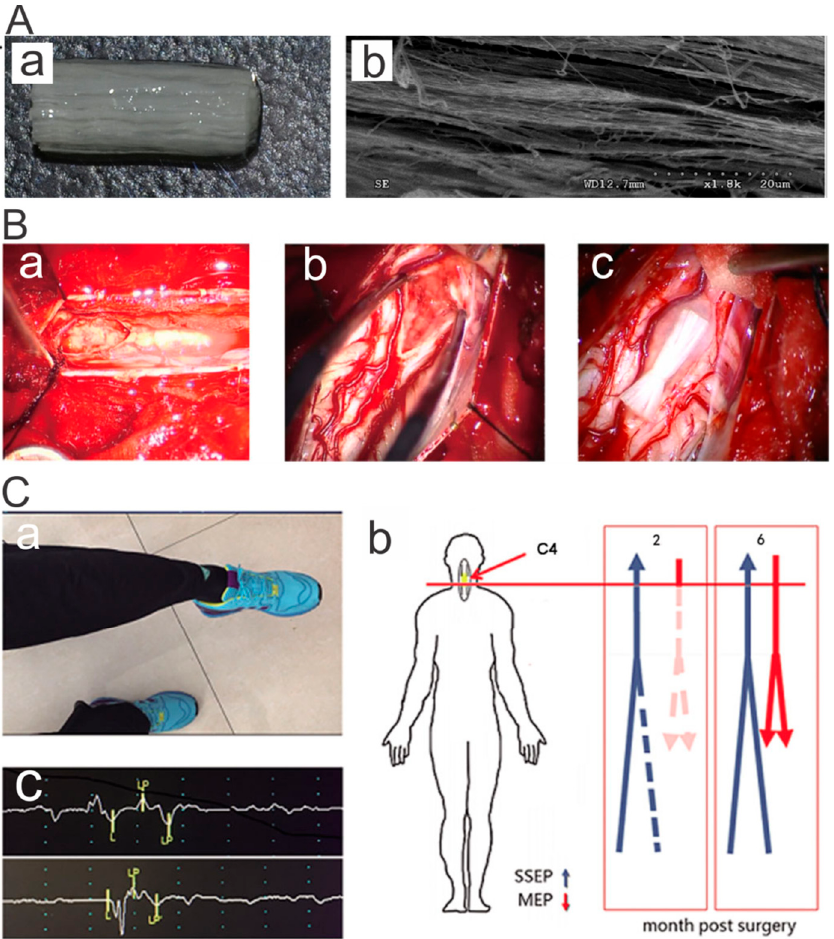
Figure 8. Aligned collagen microfibers promoted functional recovery of SCI patients. ( A ) ( a ) Photograph and ( b ) SEM image of a NeuroRegen scaffold composed of aligned microfibers. Reprinted from Reference [63]. ( B ) Intraoperative photographs of the SCI site. The lesion site was filled with necrosis tissue in ( a ) a thoracic SCI patient, and ( b ) a cervical SCI patient. ( c ) NeuroRegen scaffold transplantation into the spinal cord gap of a cervical SCI patient. Reprinted from Reference [71]. ( C ) NeuroRegen scaffolds with MSC transplantation improved the functional recovery of acute cervical SCI patients. Reprinted from Reference [71].